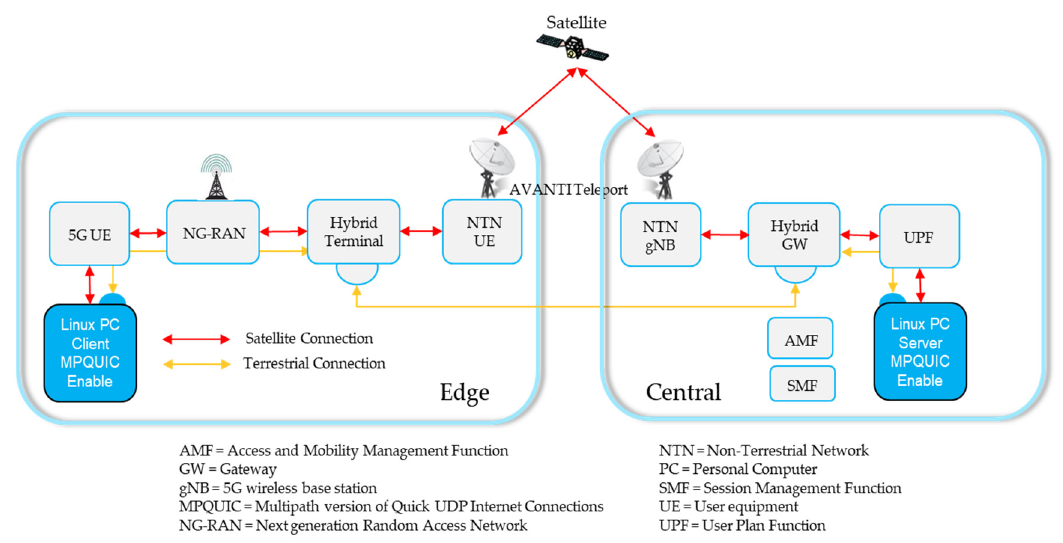
Figure 10. SaT5G Architecture for Use Case 3: 5G Hybrid backhauling using multilinking testbed.